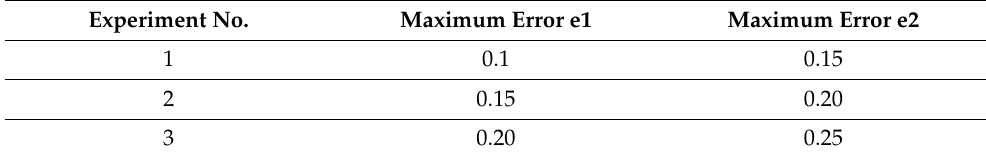
Table 5. Changes in uncertainty parameters.